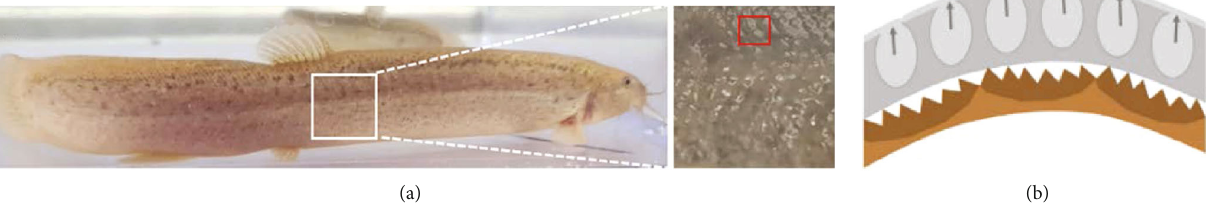
Figure 3: Loach skin map: (a) loach skin sampling map and (b) loach skin cross-section map [30].